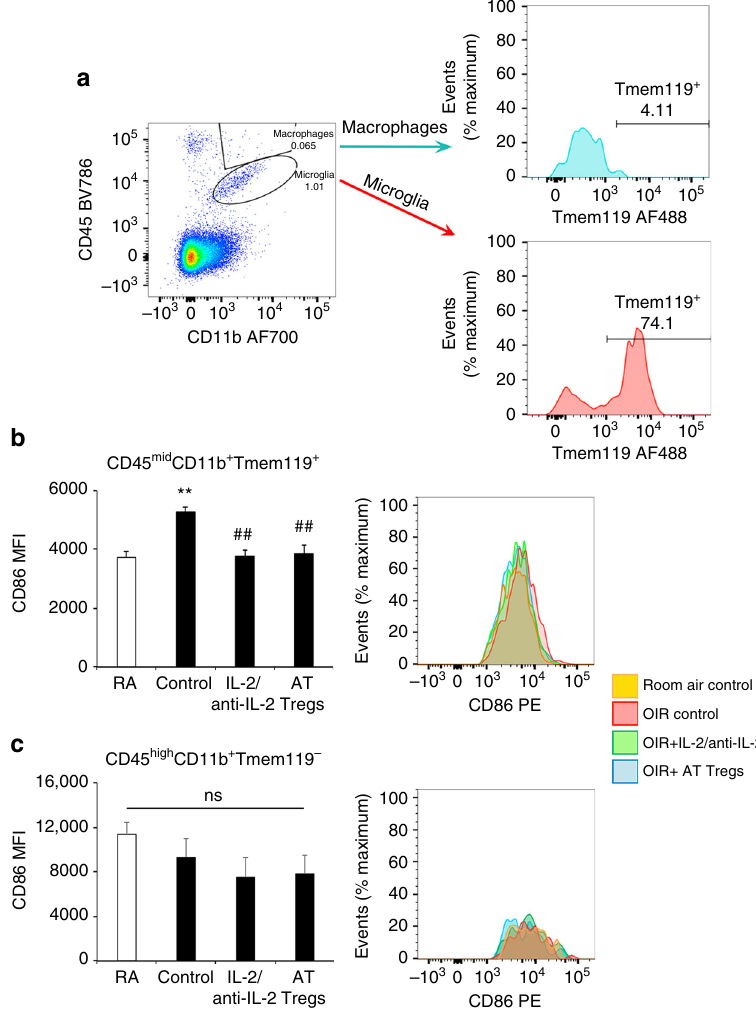
Fig. 5 Expanding Treg numbers altered the activation state of microglia. Flow cytometry of retina from C57BL/6J mice at postnatal day 10 in phase I OIR. Fluorochromes are AF700, AF488 and phycoerythrin (PE). a FACS plot schema showing cell populations in OIR retina revealed by CD45 and CD11b staining. Microglia (CD45 mid CD11b + ) rather than macrophages (CD45 high CD11b + ) predominate and Tmem119 is restricted to CD45 mid CD11b + microglia. b Mean fl uorescence intensity (MFI) of CD86 in CD45 mid CD11b + Tmem119 + microglia showing an increase with OIR compared to room air controls (RA), and a reduction in OIR mice following treatment with the IL-2/anti-IL-2 mAb complex and adoptively transferred (AT) Tregs. c MFI of CD86 in CD45 high CD11b + Tmem119 − macrophages showing no change with OIR compared to RA or the treatments. ** P < 0.01 to RA. ## P < 0.01 to OIR control (one-way ANOVA with Mann – Whitney U test). NS, not signi fi cant. n = 5 mice group. Values are expressed as mean ±